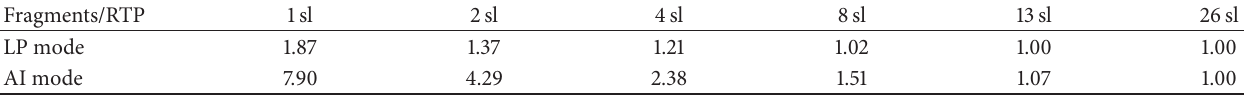
Table 1: Mean proportion of fragments (network packets) for every RTP packet (slice). Fragments/RTP